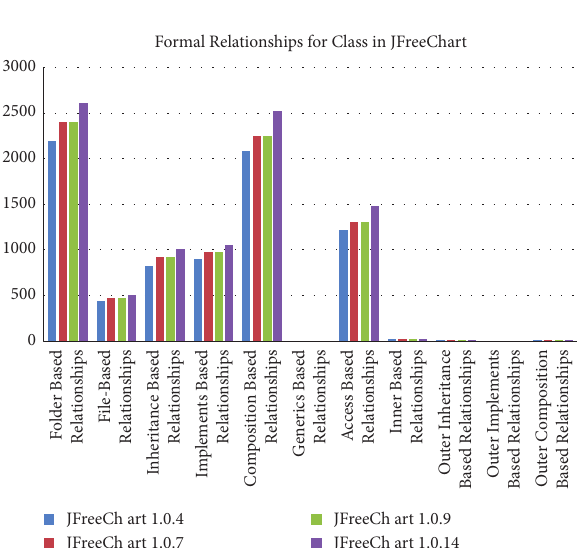
Figure 11: Count number of formal relationships for class in JfreeChart.